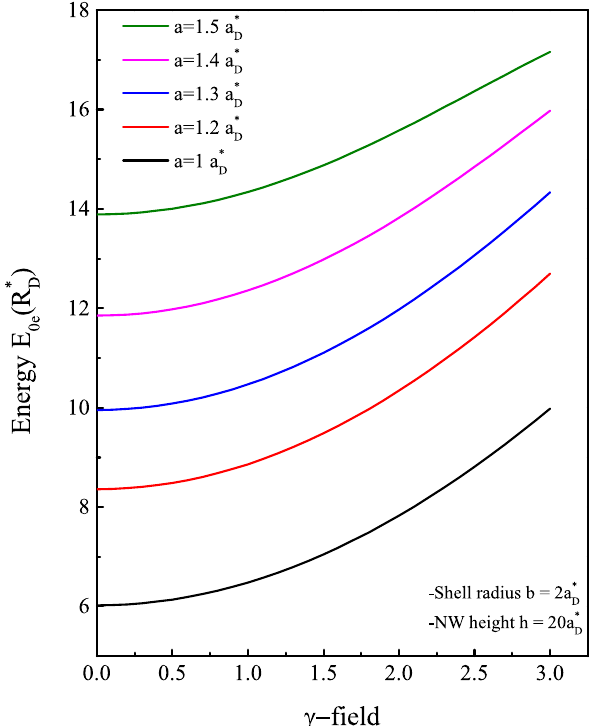
Figure 5. Variation of the electron ground state energy inside Al x Ga 1 − x As/GaAs-based core/shell NW, as a function of the magnetic field for different values of the core radius: from 1 by 0.1 to 1.5 a ∗ . The pace of evolution is semi-parabolic, the magnetic field has a remarkable effect only from an D intensity γ ≥